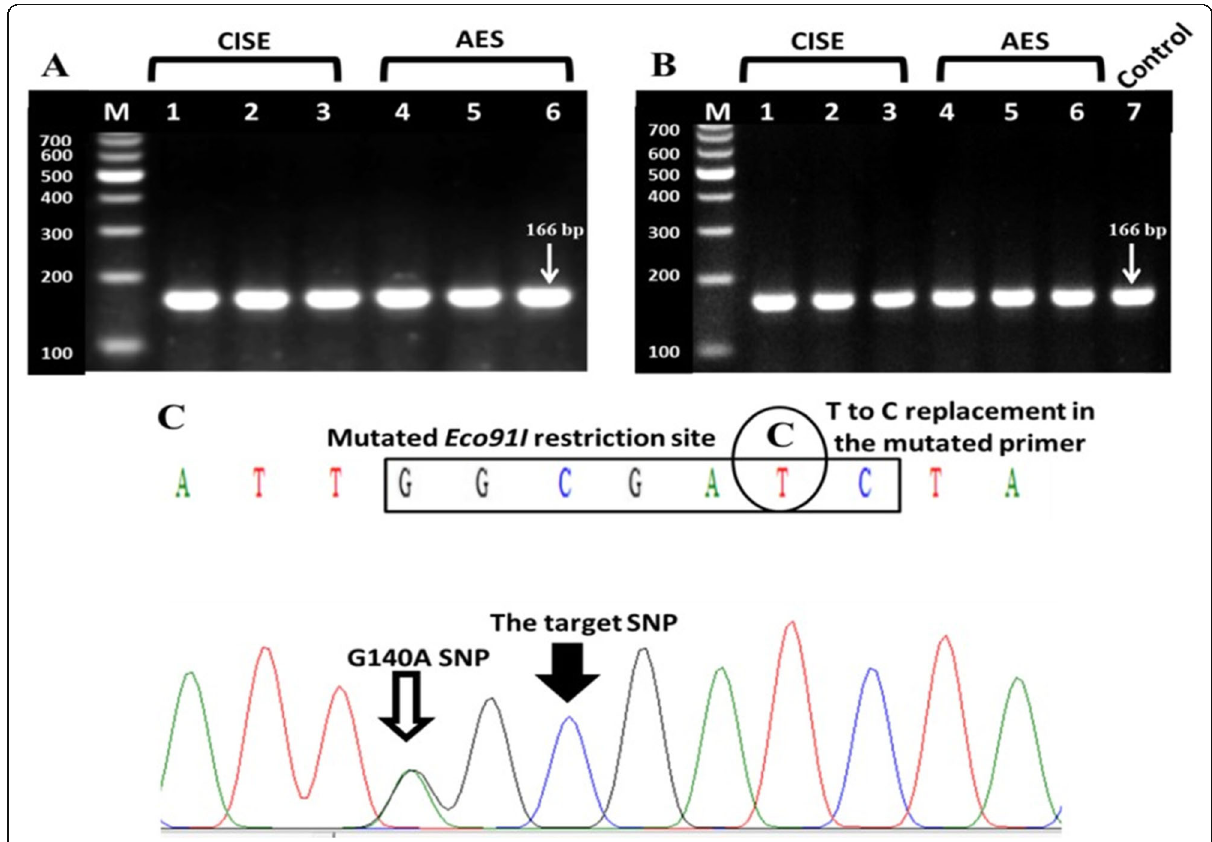
Fig. 1 The PCR product, PCR-RFLP pattern, and sequencing result of the amplified LEP gene fragment. a The PCR product of LEP fragment. b The PCR-RFLP pattern of the LEP gene amplicon. c A part of LEP fragment sequencing chromatogram. CISE: Cattle Information System/Egypt. AES: Agricultural Experiments Station. M: 100 bp molecular